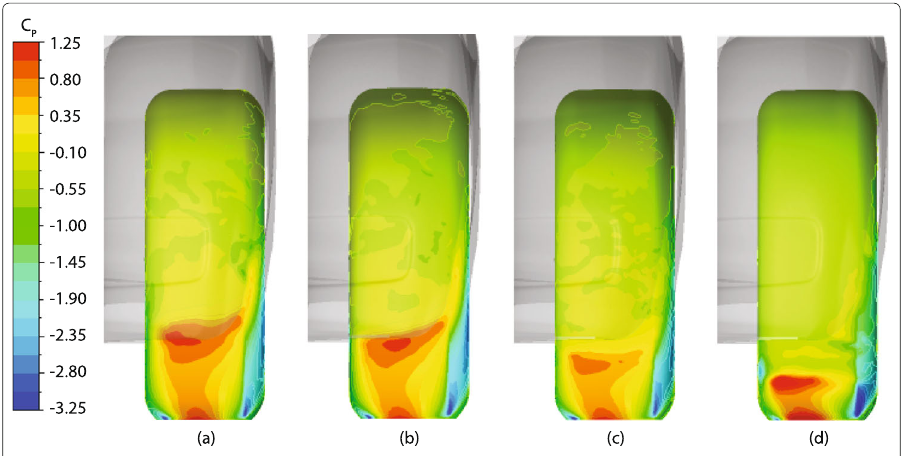
Fig. 14 Pressure coefficient contours on the front left wheel of the notchback DrivAer reference model at U ∞ = 15 m/s ( a ) baseline, ( b ) 90 ◦ air jet with U = 1/3, ( c ) 90 ◦ air jet with U = 3/3, and ( d ) 90 ◦ air jet with U =